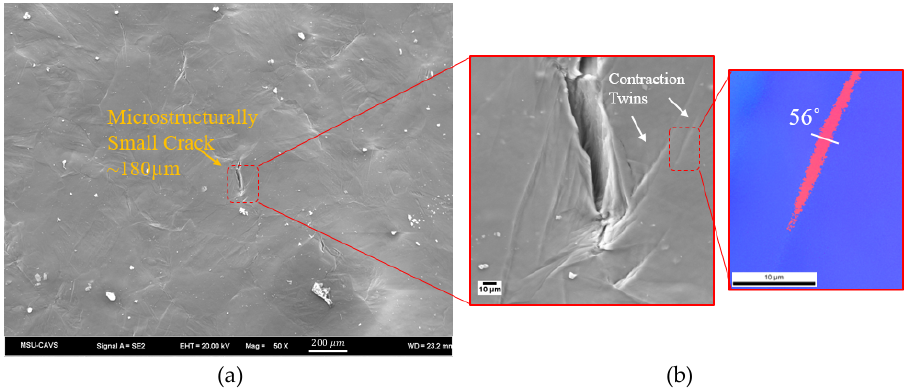
Figure 11. ( a ) Crack formation due to contraction twin interactions and ( b ) EBSD micrograph showing the contraction twins with a misorientation of 56 ◦ .